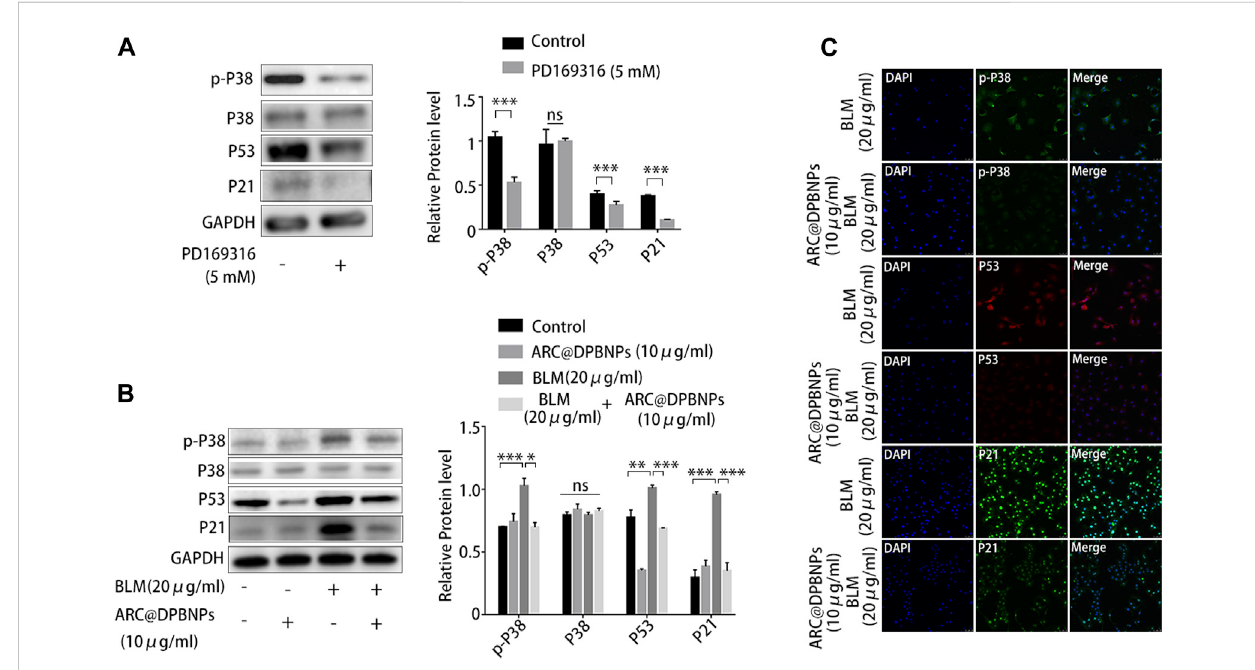
FIGURE 8 Arctiin-encapsulated DSPE-PEG bubble-like nanoparticles (ARC@DPBNPs) attenuated A549 senescence inhibiting the p38/p53/p21 pathway. (A) Western blot showing PD169316 selectively inhibits the kinase activity of phosphorylated p38 and p38/p53/p21 pathway activation. (B) Western blot showing that ARC@DPBNPs signi fi cantly attenuated A549 senescence by downregulating p-p38 MAPK , p53, and p21 expression. (C) Immuno fl uorescence staining of p-p38 MAPK , p53, and p21 in A549 cells treated with PBS, ARC@DPBNPs (10 μ g/mL), bleomycin (BLM) (20 μ g/mL), and BLM (20 μ g/mL) + ARC@DPBNPs (10 μ g/mL) respectively. * p < 0.05, ** p < 0.01, *** p < 0.001; ns: not signi fi